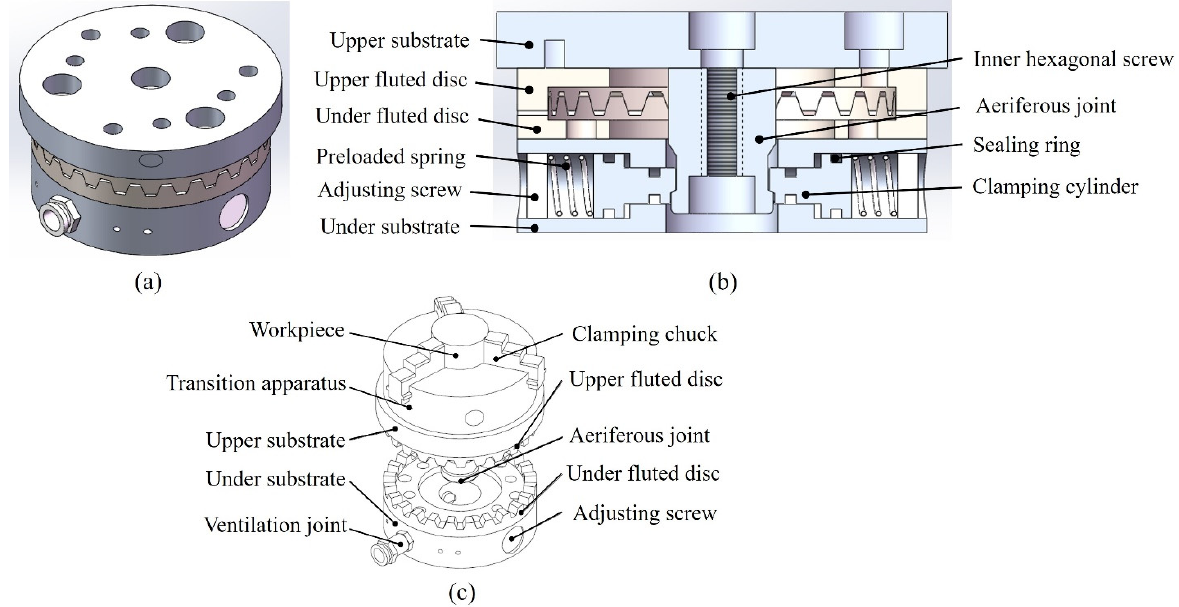
Figure 1. ( a ) Three-dimensional structure diagram of the proposed high-precision positioner fixture. ( b ) Sectional view of the proposed positioner fixture. ( c ) Structure diagram of the proposed positioner fixture with the workpiece.